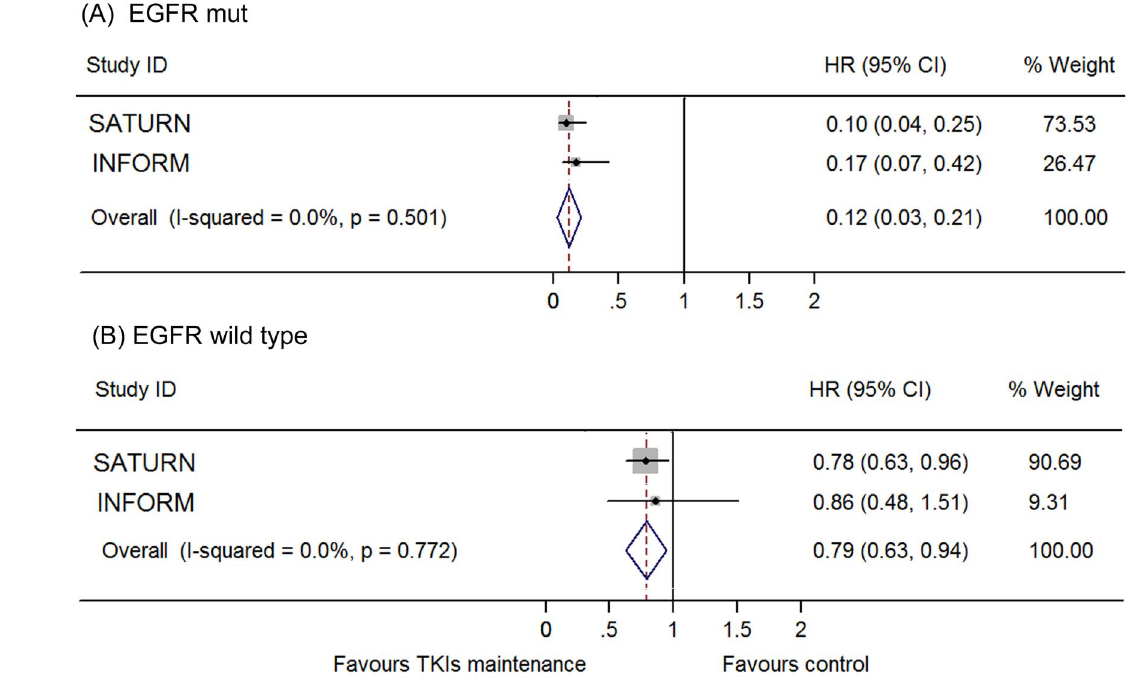
Figure 3. Meta-analysis of hazard ratio (HR) for progression free survival (PFS) according to EGFR mutation status. (A) EGFR mutation positive. (B) EGFR wild type. doi:10.1371/journal.pone.0059314.g003 PLOS ONE |